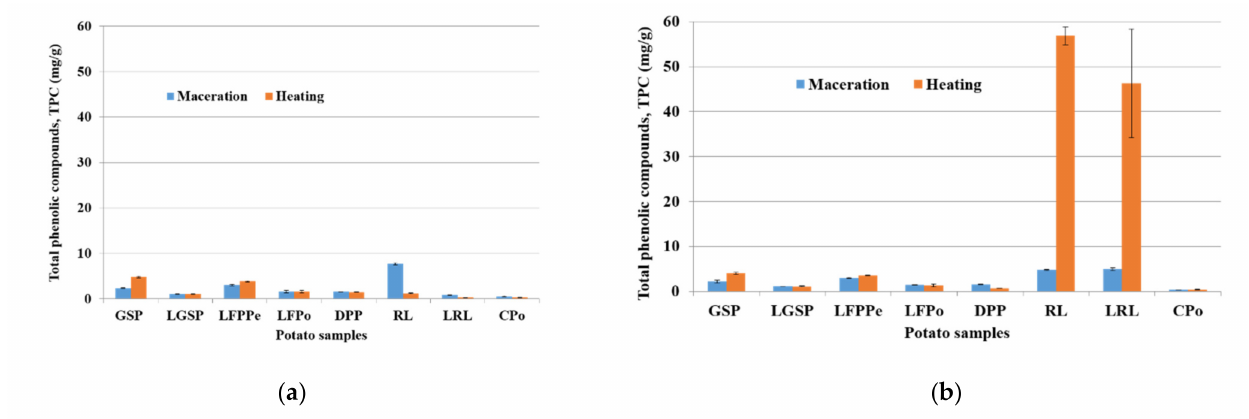
Figure 1. Effect of two extraction methods on potato by-products at on TPC content, ( a ) MeOH: H 2 O; 4:1 and ( b ) EtOH: H 2 O; 4:1